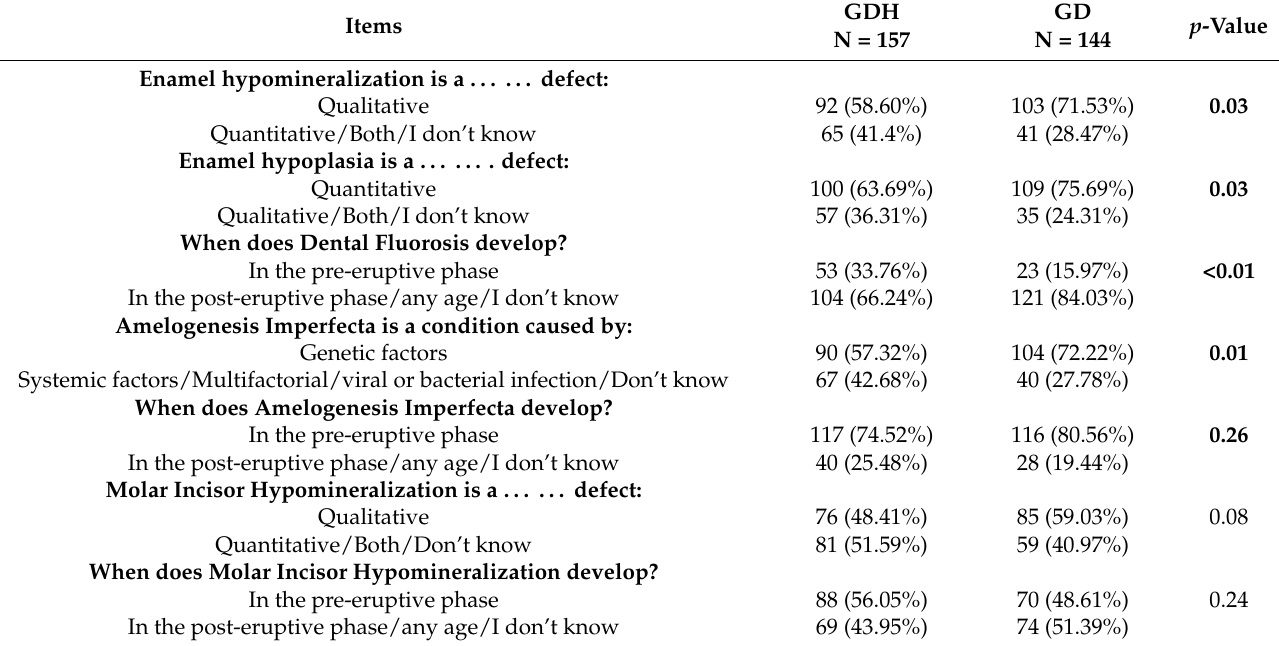
Table 1. DDE knowledge among GDH and GD (expressed as number and percentage). The difference between groups was analyzed by Pearson’s chi-square test.